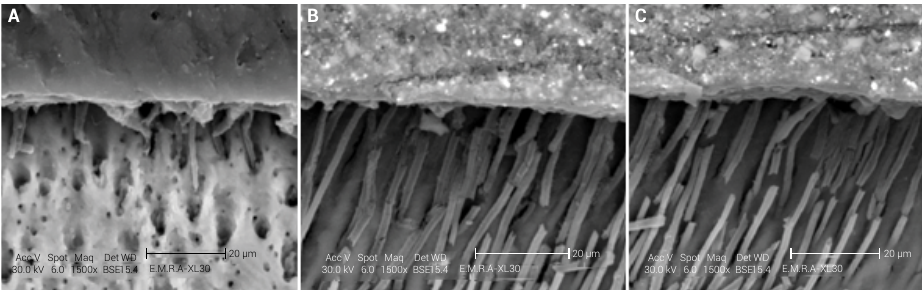
Figure 2. Scanning electron micrograph (1000X) of the interface at sealer/ dentin using A:ADSEAL, B: Well-Root and C: Ceraseal.